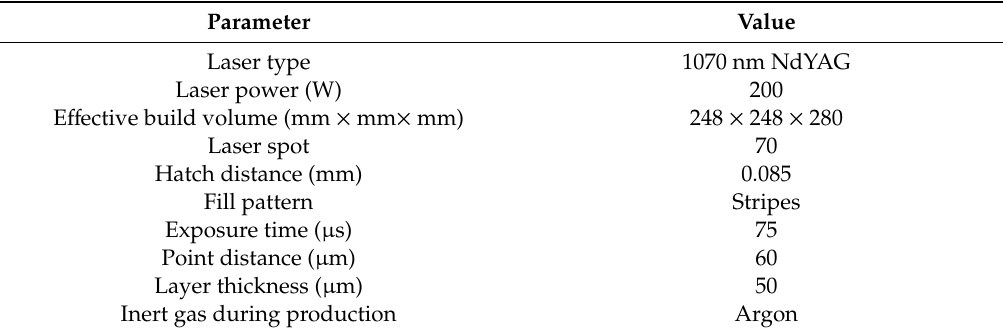
Table 2. Selective laser melting (SLM) machine